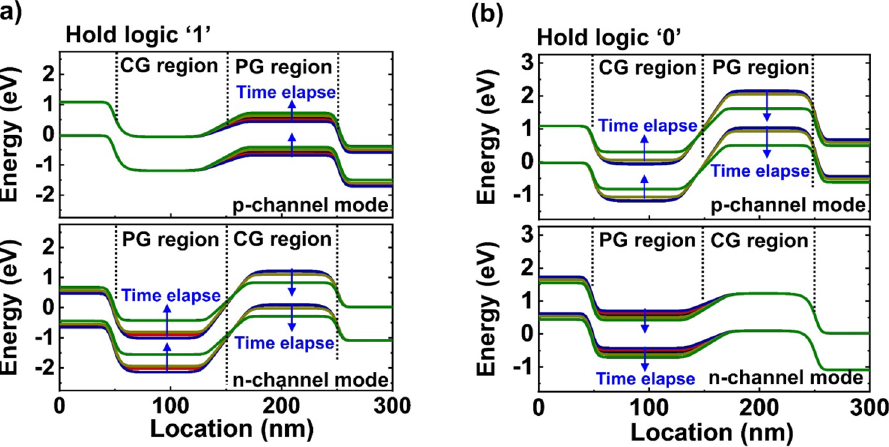
Figure 6. Energy band diagrams of the DG FBFETs in the n- and p-channel modes while holding the output logic ( a ) ‘1’ and ( b ) ‘0’